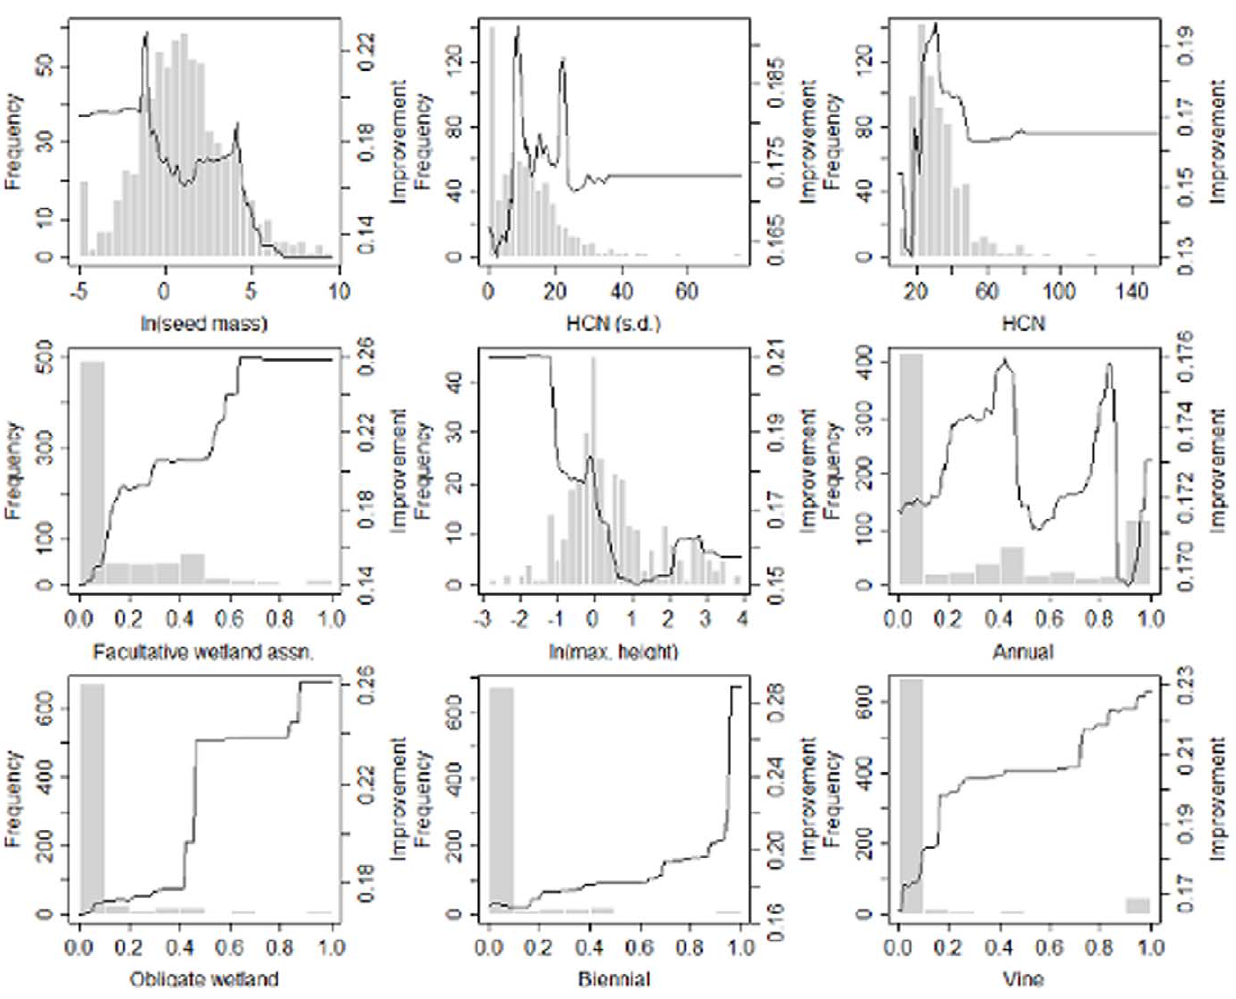
Figure 1. Marginal plots (improvements of the GBM model predicting weed proportion as a function of a single explanatory variable [ 46 ] ) overlaid on a frequency histogram (summarizing over the entire dataset of 760 genera) of each explanatory variable. Right hand y-axis is the log-odds ratio for GBM models. Graphs are arranged by order of explanatory variable importance. HCN= highest chromosome number mean, and HCN (s.d.) = standard deviation in highest chromosome number by genus.